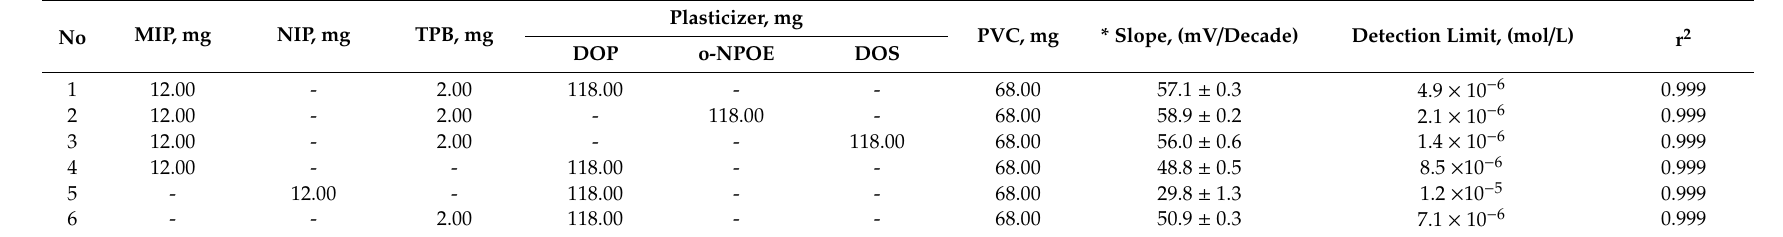
Table 1. The potentiometric response of the fluoxetine (FLX) membranes